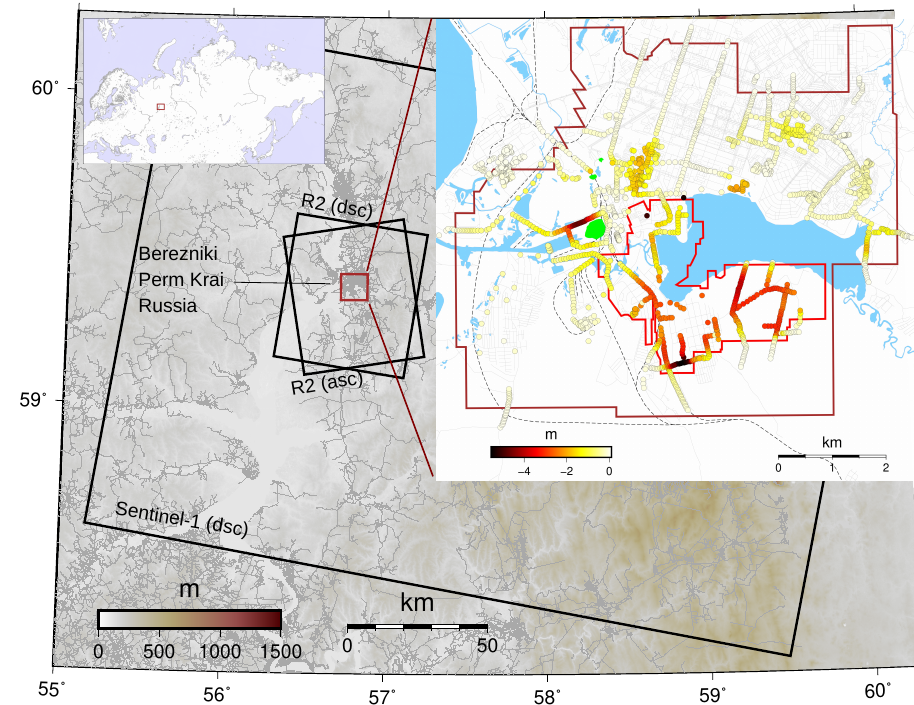
Figure 1. Area of interest (AOI, brown rectangle) is city of Berezniki in Perm Krai, Russia. Outlines of RADARSAT-2 and Sentinel-1 swaths are shown in black. Background is 30 m Shuttle Radar Topography Mission (SRTM) digital elevation model. OpenStreetMap data (downloaded from http://download.geofabrik.de.) is shown as grey lines. Left insert shows location of AOI in Eurasia. Right insert shows cumulative ground subsidence since at least 2012 measured by precise leveling. Rail roads are shown as dashed lines. Three sinkholes are shown as green polygons. The outlines of mining operations of carnallite (seam B) and sylvinite (seam Kr II) are shown as red and brown polygons,